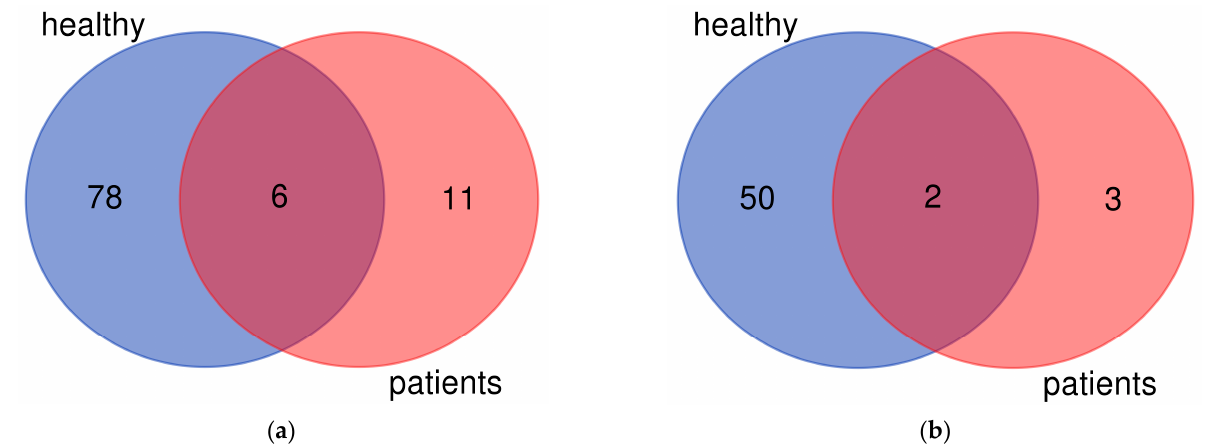
Figure 1. Venn diagrams presenting di ff erentially expressed genes . The overlap between the genes that are upregulated ( a ) or downregulated ( b ) after exposure to 1,25D of the cells from healthy volunteers and from patients. Figure 1 was prepared using an online tool available